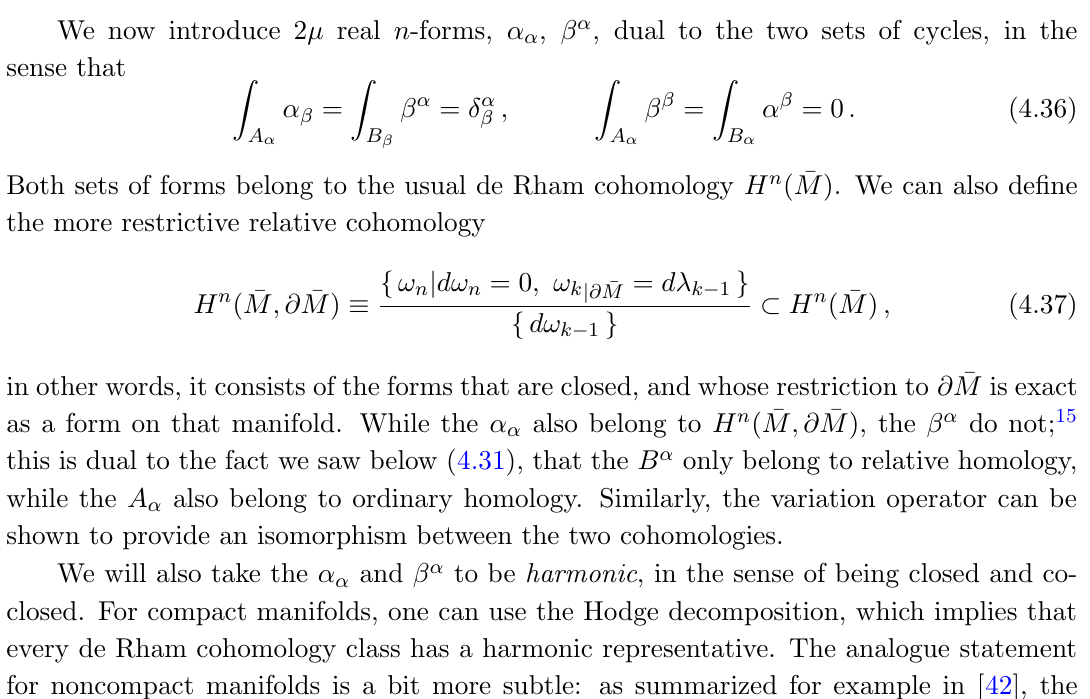
Figure 4 . Left: a basis of one compact and one noncompact cycle for the singularity in (cid:12)gure 2. Right: the noncompact cycle before and after a monodromy; the di(cid:11)erence of the two noncompact cycles is homologous to the compact